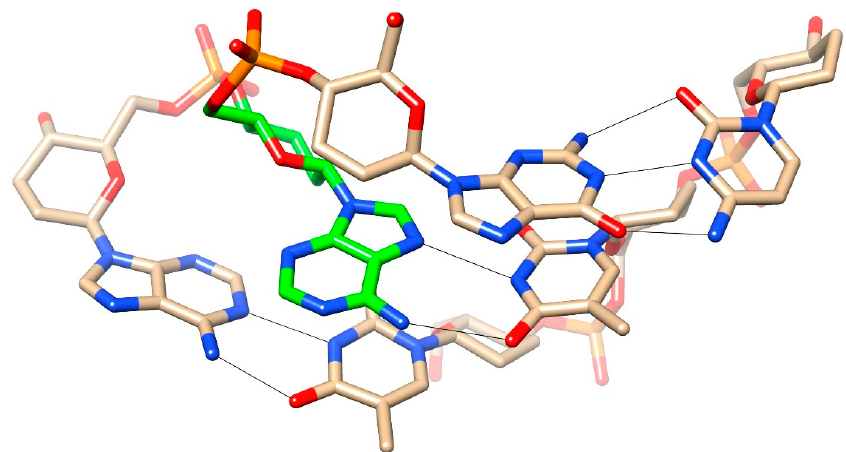
Figure 8. An adenosine that adopted an extrahelical orientation in the homo-DNA crystal structure re-inserted into the stack (highlighted with green carbon atoms) during the molecular dynamics (MD) simulation of the isolated duplex and then formed a Hoogsteen pair with the T from the opposite strand. Note the orientation of the hexose sugar of the re-paired A that was roughly perpendicular relative to sugars of neighboring intra-strand residues.